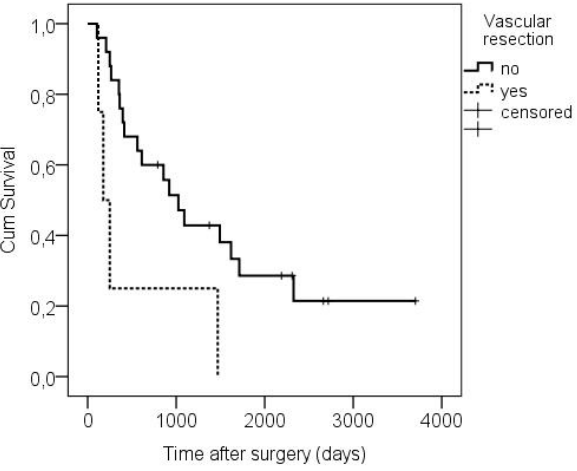
Fig. 2. Overall survival stratified by performing of vascular re- section estimated using the Kaplan-Meier analysis ( P